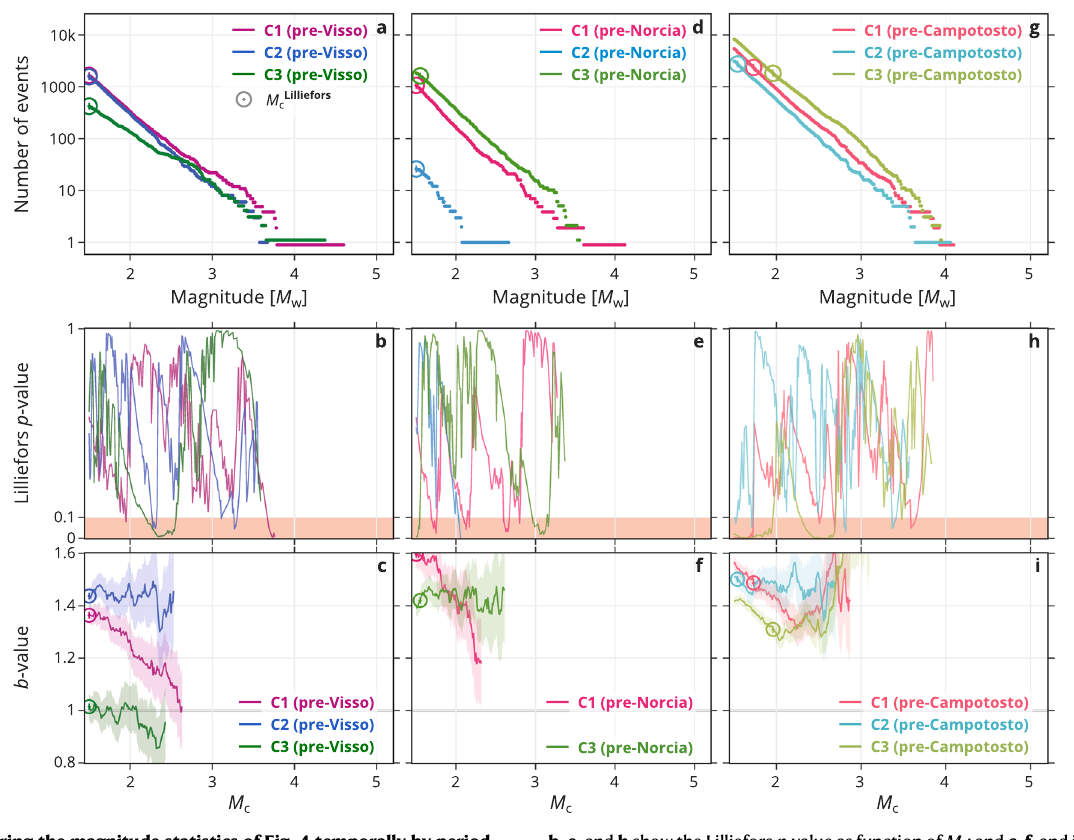
Fig. 5 | Reordering the magnitude statistics of Fig. 4 temporally by period. a – c ‘ pre-Visso ’ , d – f `pre-Norcia', and g – i `pre-Campotosto'. Like Figs. 3 and 4, a , d , and g show clusters in terms of their magnitude – frequency distribution;